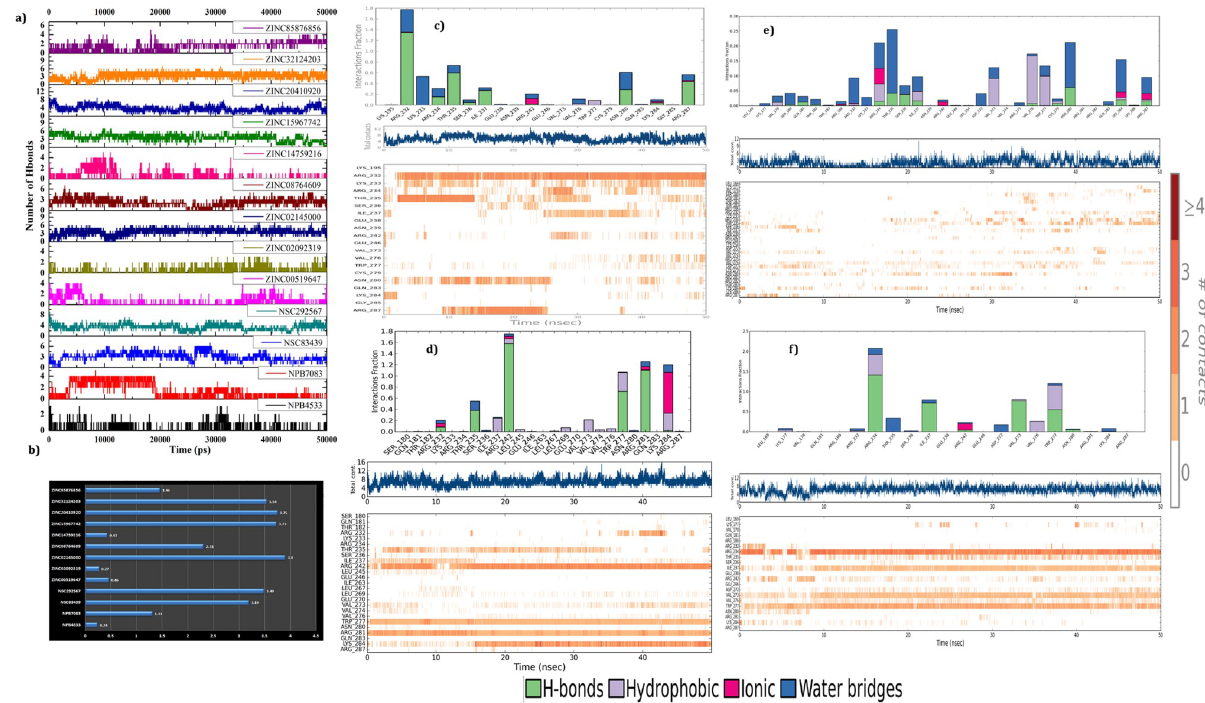
Fig 10. The intermolecular hydrogen bonds formed by screened compounds with Oct4 during the 50ns molecular dynamics simulation. a) Number of H-bonds established between protein-ligand complexes; b) Average mean variations plot of H-bond interaction; c) The H-bond occupancy throughout the trajectory for NSC83439, (d) ZINC02145000, (e) NPB4533 and (f) ZINC32124203 where the top panel represents the overall interaction of the protein with ligands and bottom panel unveiled the name of interactive amino acid